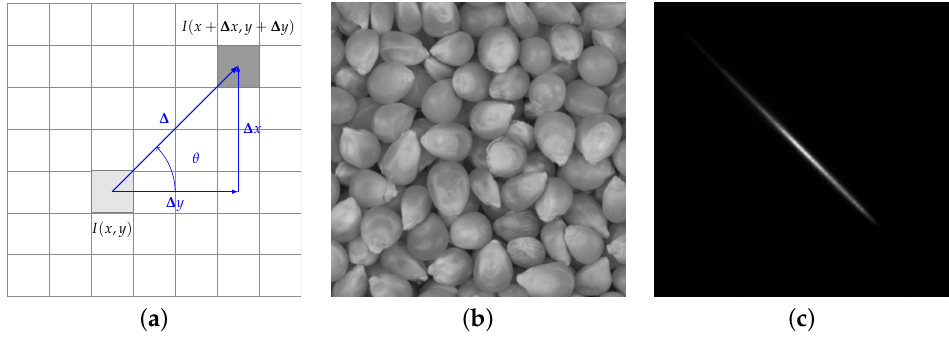
Figure 4. Grey-level co-occurrence matrices. From left to right: ( a ) mathematical formulation, ( b ) sample image and ( c ) corresponding GLCM ( δ = 3 √ 2 px, θ = 45 ◦ ). In ( a ) each square of the grid represents one pixel; ( x , y ) indicates the coordinates and I ( x , y ) the grey-level intensity. Sample image ( b ) sourced from RawFooT DB